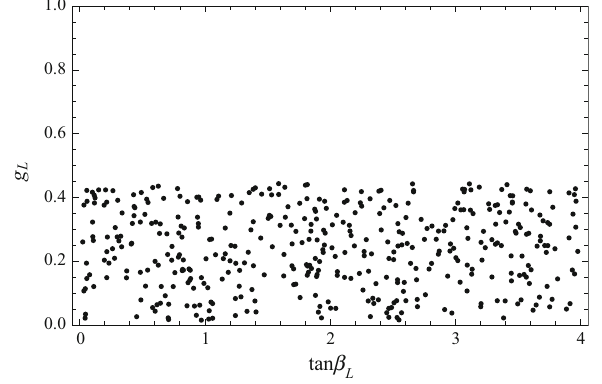
Fig. 6 For μ → e conversion rate in nuclei Au, the allowed parameter space in the plane of tan β L versus g L with m 1 = 1000GeV, m 2 = 1000GeV, tan β = 6, S 2 m = 12TeV 2 , M Lf = 10 4 GeV 2 and V Lt =